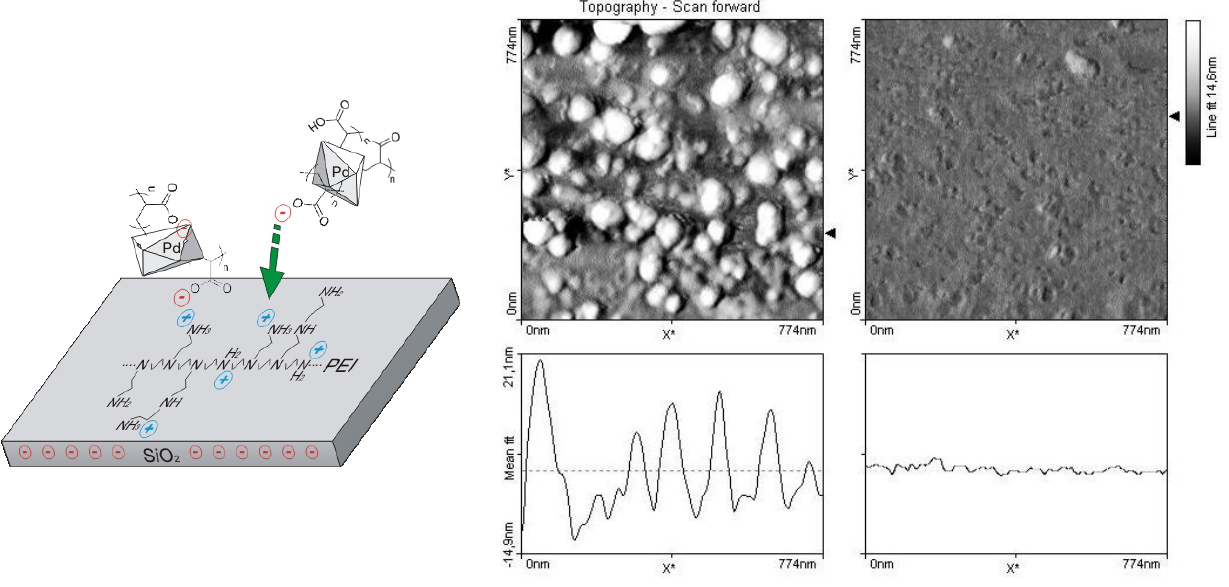
Figure 6. Coating and AFM scan of palladium nanoparticles (used as catalytic seeds in the fluidic device).